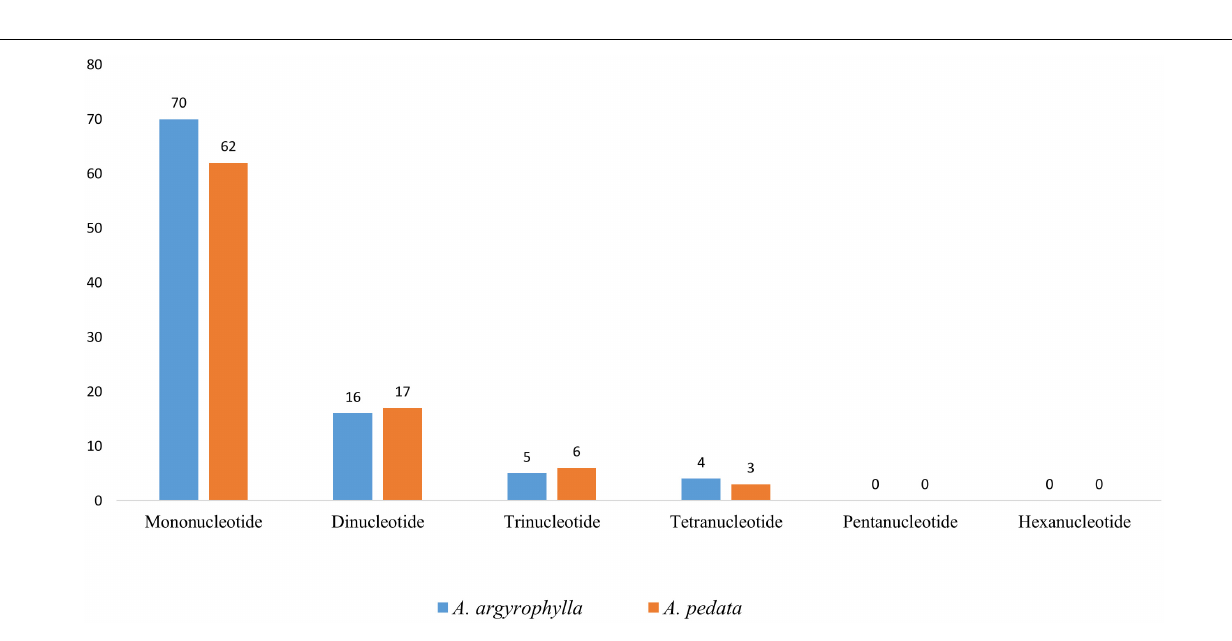
FIGURE 3 | Number of different simple sequence repeat (SSR) units in Alchemilla argyrophylla and Alchemilla pedata comprising mono-, di-, tri, tetra-, penta-, and hexa-nucleotide repeats.